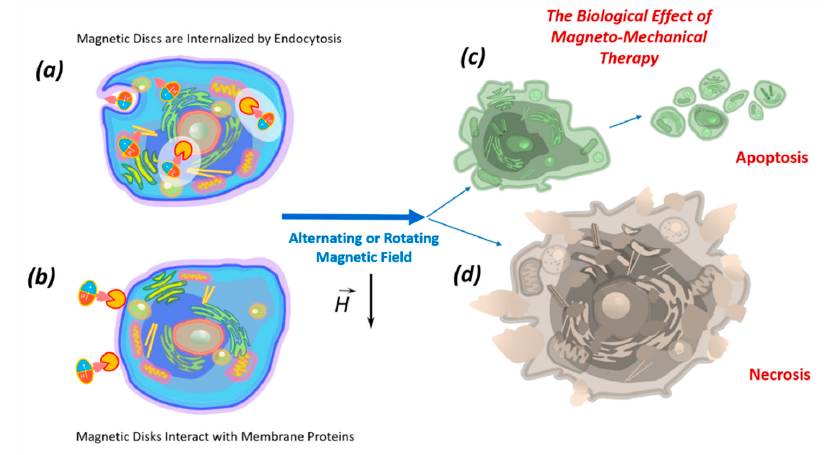
Figure 3. The biological effects of magnetic nano- or microdiscs functionalized by recognizing molecules, which in the low-frequency magnetic field act inside the cell after internalization by endocytosis ( a ) or directly influence the cellular membrane by interacting with membrane proteins ( b ), causing apoptosis ( c ) or necrosis ( d ).